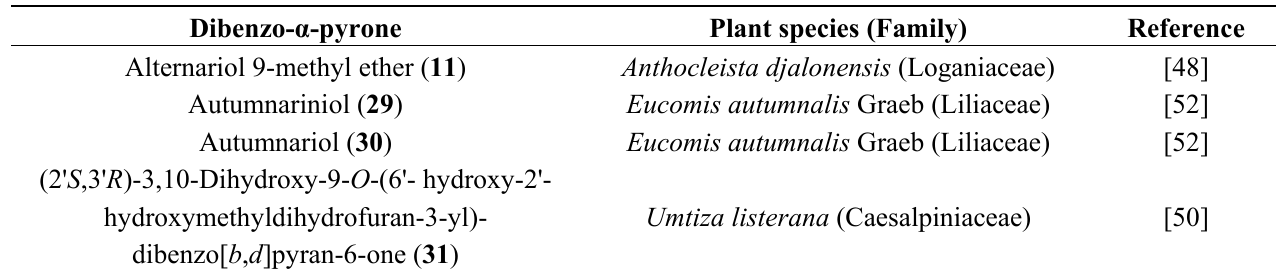
Table 2. Occurrence of dibenzo- α -pyrones in